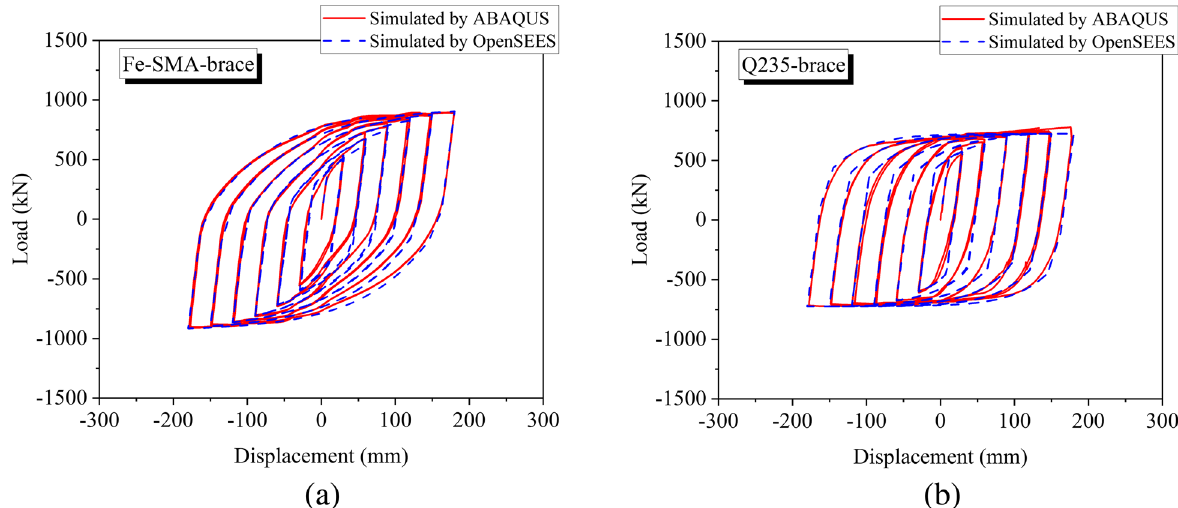
Fig. 20 Comparison of finite element simulation results simulated by ABAQUS and OpenSEES platforms